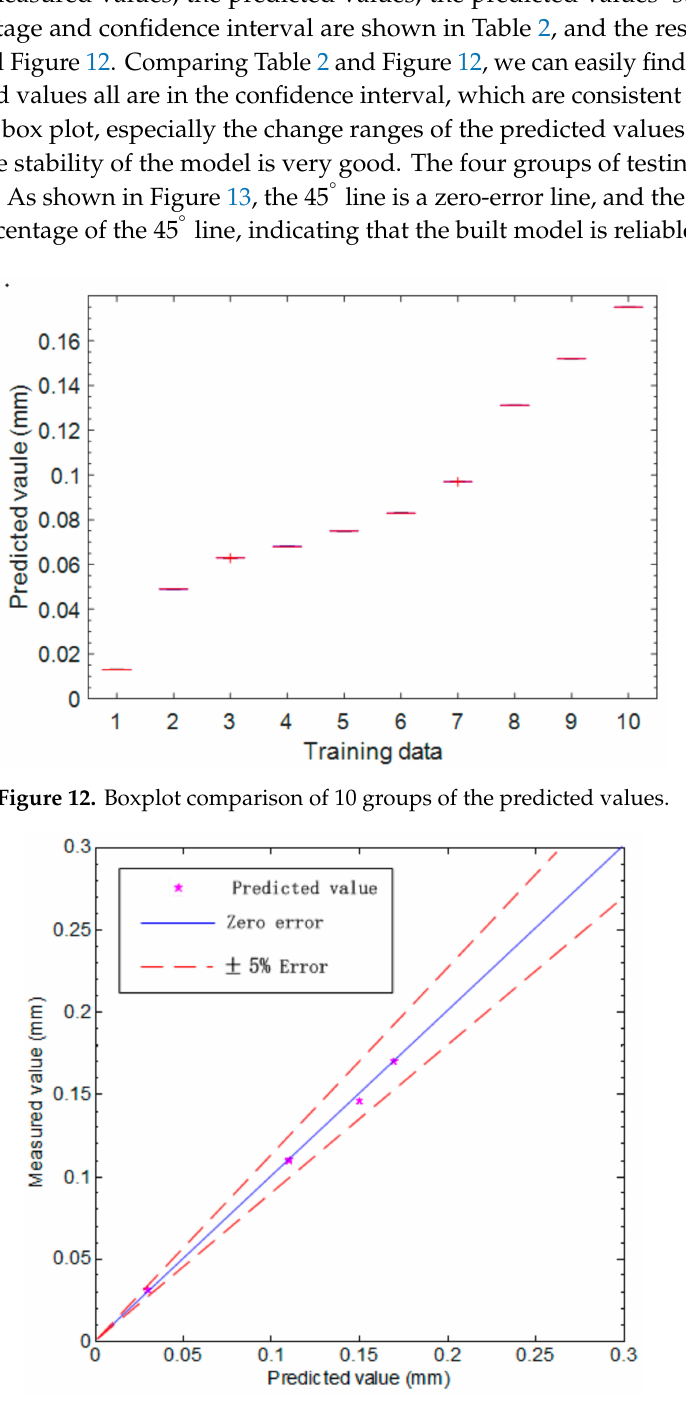
Figure 13. A scatter chart of the predicted value of testing data against the measured